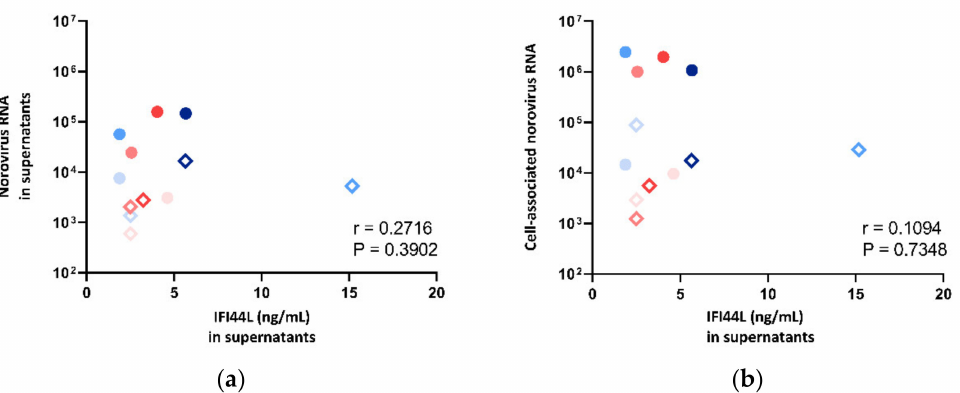
Figure 8. Correlation between norovirus RNA in ( a ) cell lysates and ( b ) supernatants against IFI44L concentration measured in supernatants, where the symbol shape indicates the enteroid line used: circles represent CUHK-ED-2, and hollow rhombuses represent CUHK-ED-3. The colour indicates the virus strain for inoculation: blue was used for CUHK-NS-1127, and pink was used for CUHK-NS-1190. The gradient of colour change illustrates the time of sampling: the lightest colour denotes 1 h post-inoculation (hpi), the colour in between denotes 24 hpi and the darkest colour indicates 72